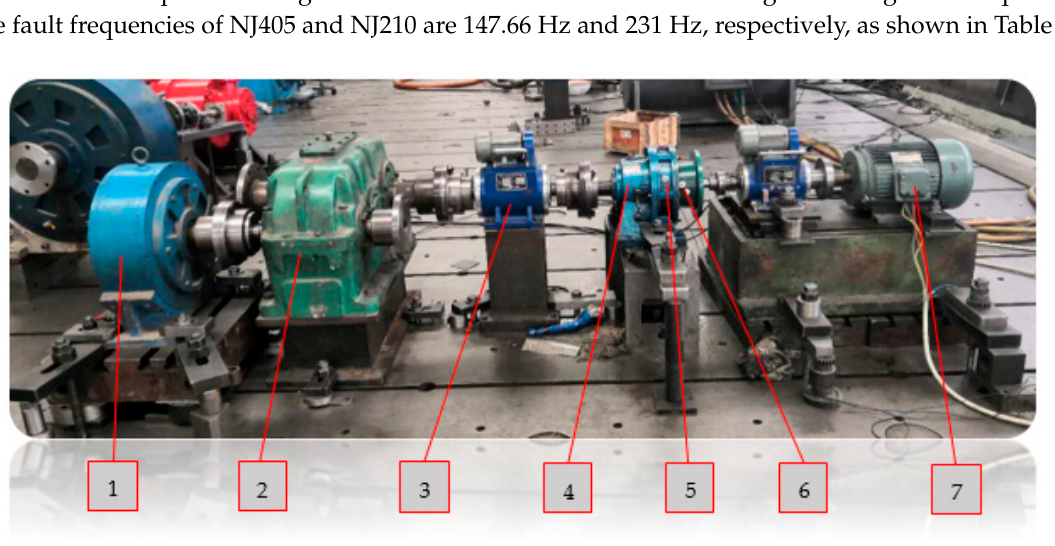
Figure 11. MSE value of the component signal (reconstructed signal is decomposed by CEEMD).